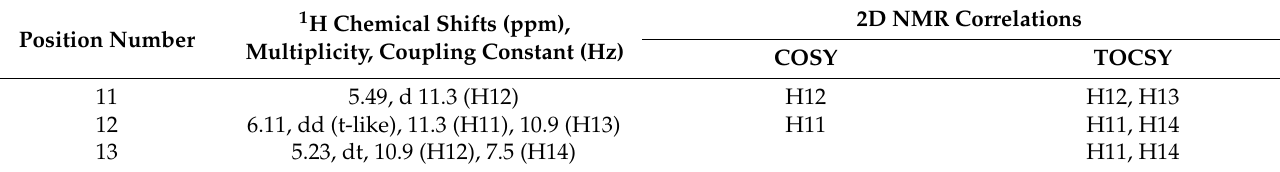
Table 2. The partial NMR spectral data for 10( Z )-isomer of allene oxide 9,10-EOD (Me ester) biosyn- thesized by LeAOS3 (CYP74A3), [ 2 H 14 ]n-hexane, 253 K. The 1 H-NMR (600 MHz) and 1 H- 1 H-COSY (600/600 MHz) data are